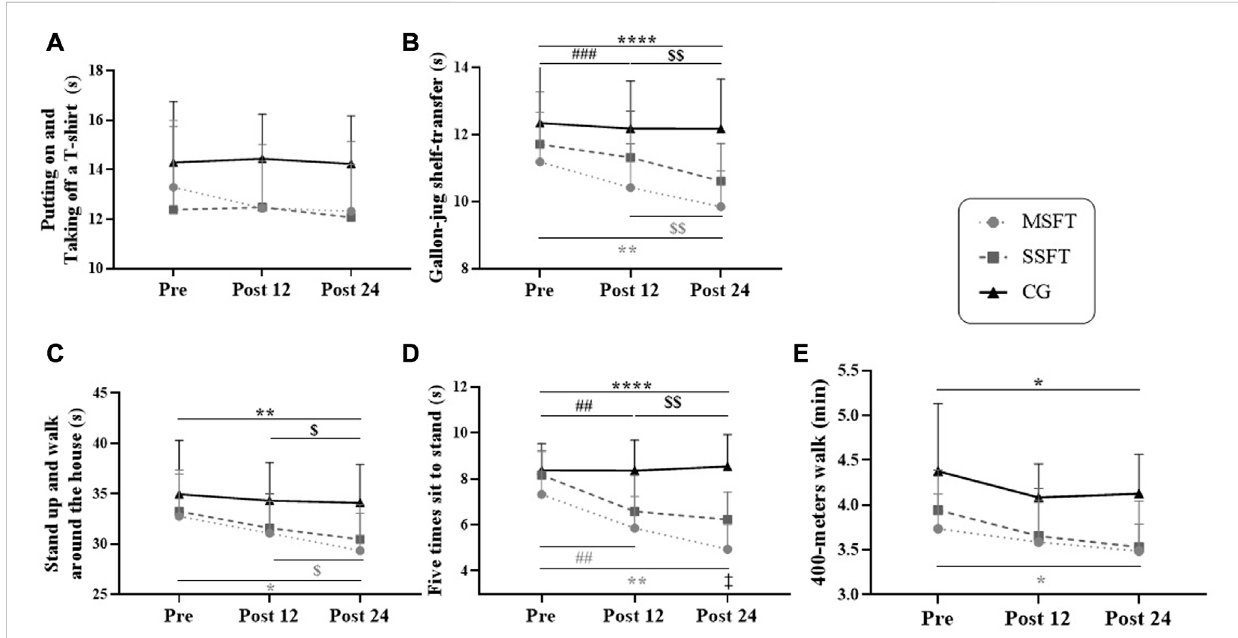
FIGURE 3 Values observed in functional fi tness tests (A) putting on and taking off a T-shirt (B) gallon-jug shelf-transfer (C) standing up and walking around the house (D) fi vetimes sit-to-stand (E) 400-m walk) regarding the control group (CG, n = 13, black line with triangles), single-set functional training (SSFT, n = 14, grey dashed line with square), and multiple-set functional training (MSFT, n = 16, grey dotted line with circles) analyzed by repeated-measures ANOVA with two factors (time × group) and Tukey ’ s multiple comparisons. Note. Values expressed as mean and standard deviation; differences observed adopting p 0.05: *post24 vs. pre; $ post24 vs. post12; # post12 vs. pre; ‡ SSFT vs. MSFT. When p < 0.01: **; $$ ; ## . p < 0.001: ***; ### . p < 0.0001: ****.